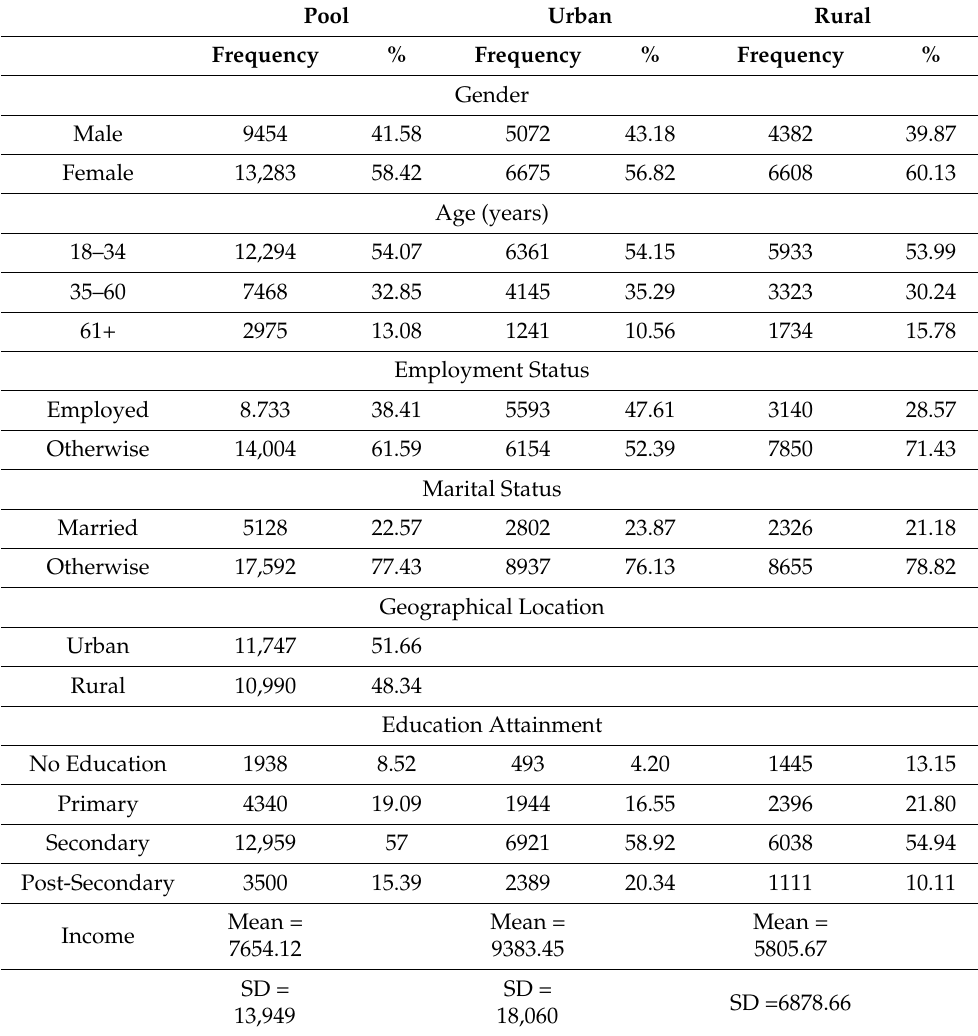
Table 2. Sociodemographic characteristics of sample.